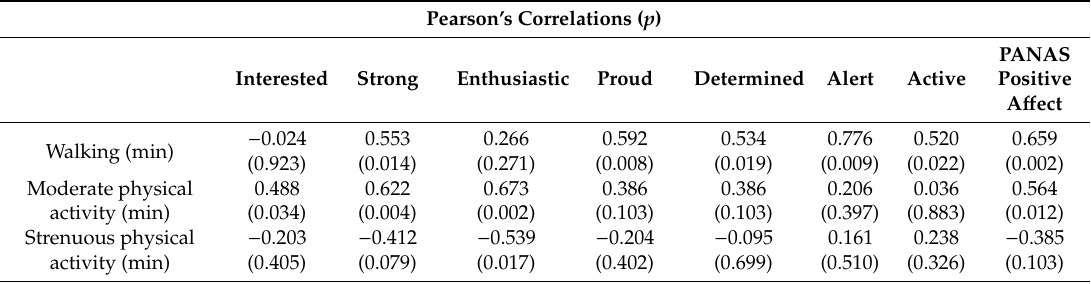
Table 3. Delta Pearson’s correlations.